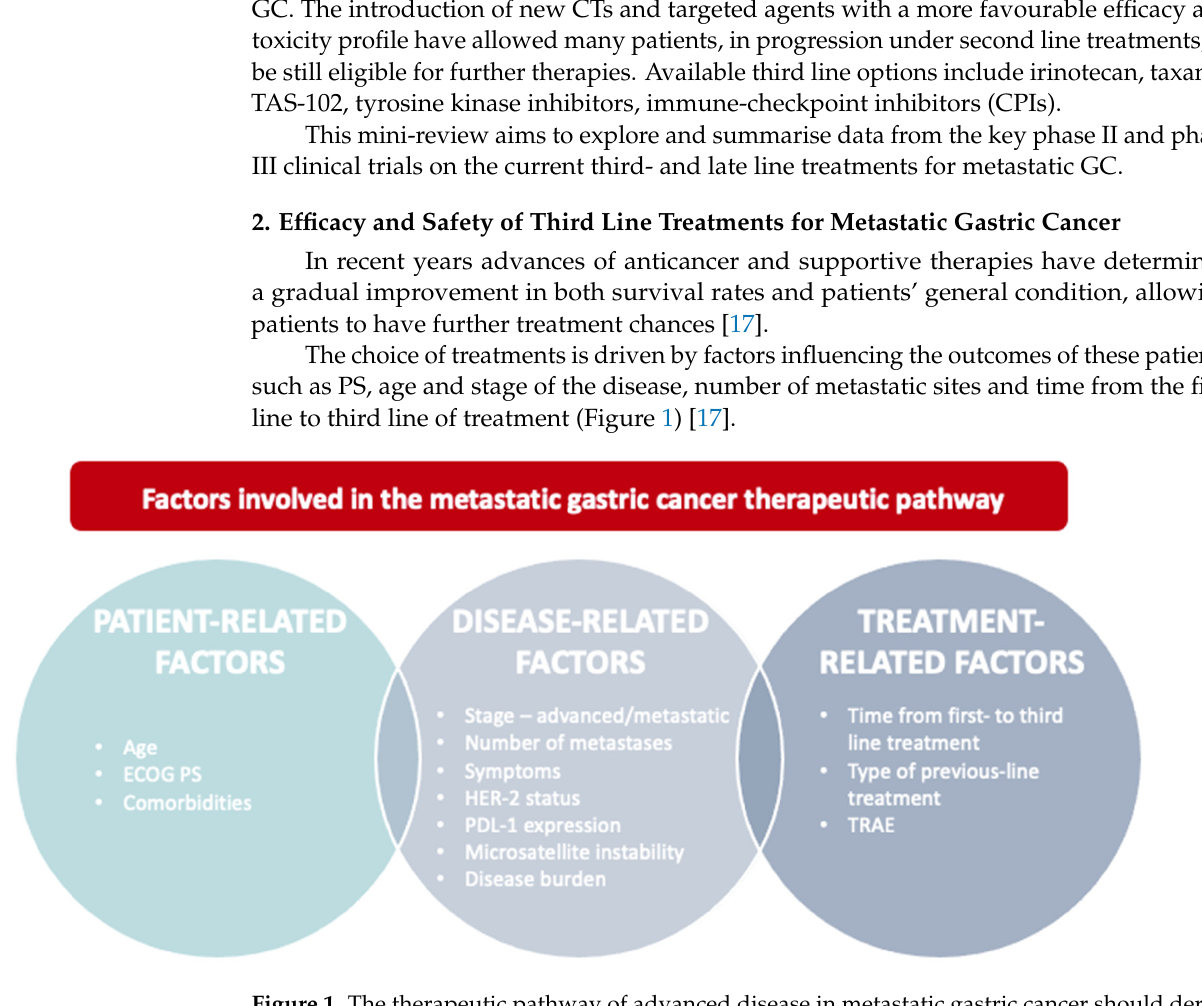
Figure 1. The therapeutic pathway of advanced disease in metastatic gastric cancer should derive from the evaluation of factors related both to patient (age, PS, comorbidities), and disease-related factors (stage—locally advanced vs. metastatic, presence or absence of symptoms and disease burden) as well as factors related to the therapy itself (type of drugs used in the first line with the related toxicities).